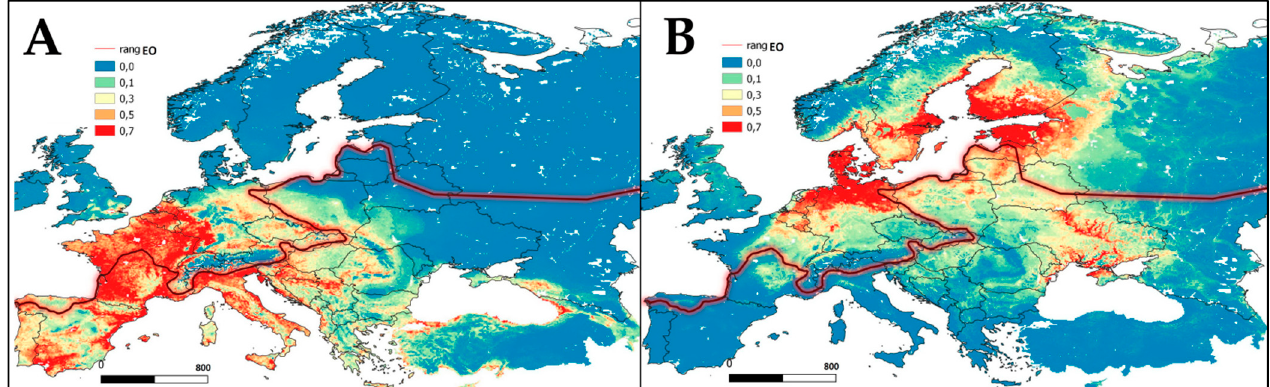
Figure 4. Potential (probabilistic) model for species expansion built in the Maxent program based on CliMond, 2090 dataset and GBIF data: ( A ) T. scripta ; ( B ) N. procyonoides . Areas with the highest habitat suitability (>0.5) are colored in red and areas with the lowest (<0.1) in blue.